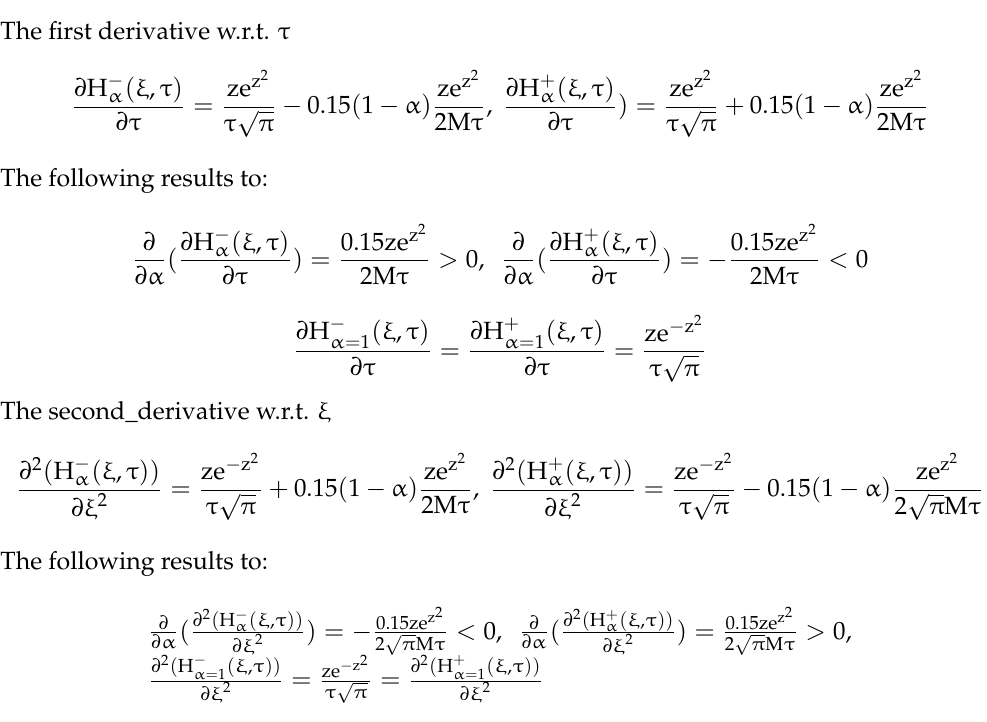
H ( ξ , τ )] α versus )]τ,ξ(H~ [ versus z. (cid:101)